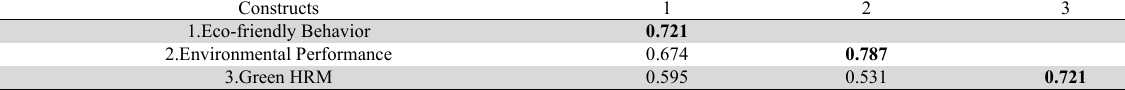
Discriminant Validity Matrix using Fornell and Lacker’s Criterion Constructs